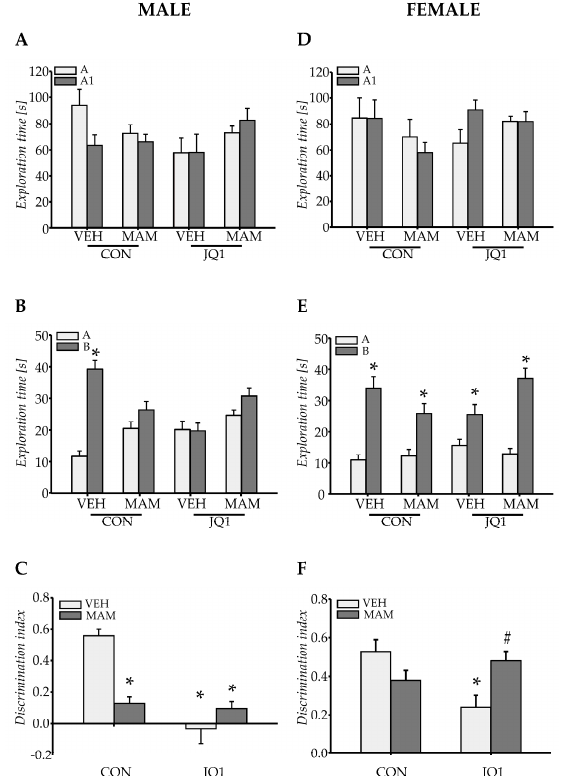
Figure 1. The effect of adolescent JQ1 administration on recognition memory in the novel object recognition test in the MAM-E17 model of schizophrenia. ( A , D ) Exploration time of two identical objects in the acquisition session, ( B , E ) exploration time of one novel and one familiar object in the retention test conducted 1 h following the acquisition session, ( C , F ) discrimination index. The rats were (males: A – C and females: D – F ) exposed to JQ1 or vehicle (CON) in early adolescence (P23–P29), and the analyses were performed in rats at P60. Each data point represents the mean ± SEM; n = 12 per group. B —* p textless 0.05 vs. familiar object (A), C —* p textless 0.05 vs. VEH-CON, # p textless 0.05 vs. MAM-CON (two-way repeated measures ANOVA ( A , B , D , E ) or two-way ANOVA ( C , F ) followed by a Tukey